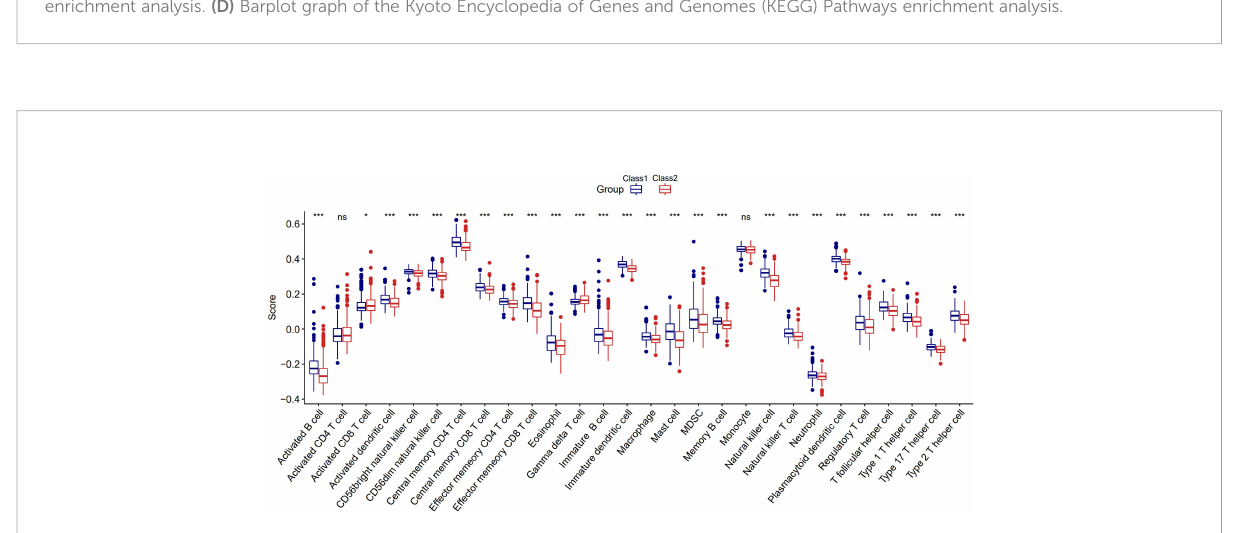
FIGURE 5 The distinct tumor immune microenvironment between the two Classes. *:p<0.05; ***:p<0.001; ns, not signi fi